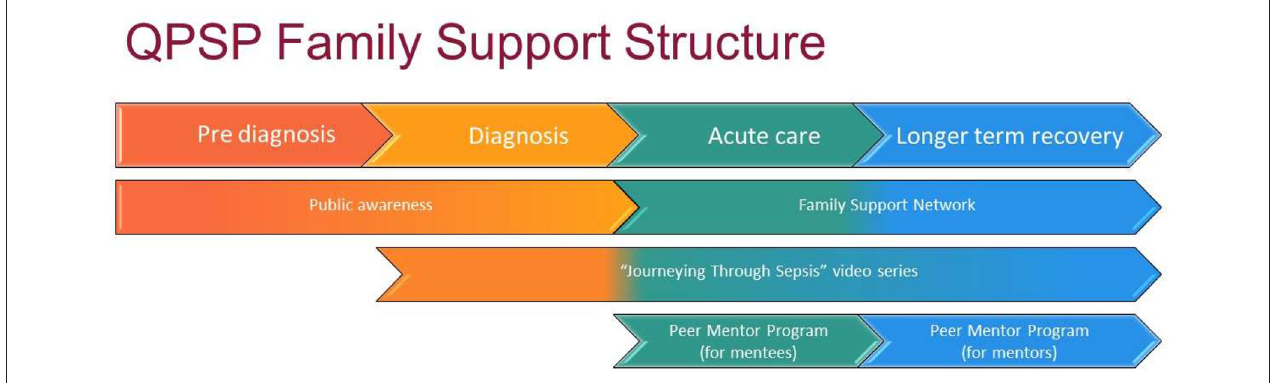
FIGURE 1 | Overview of Queensland Paediatric Sepsis Program family support